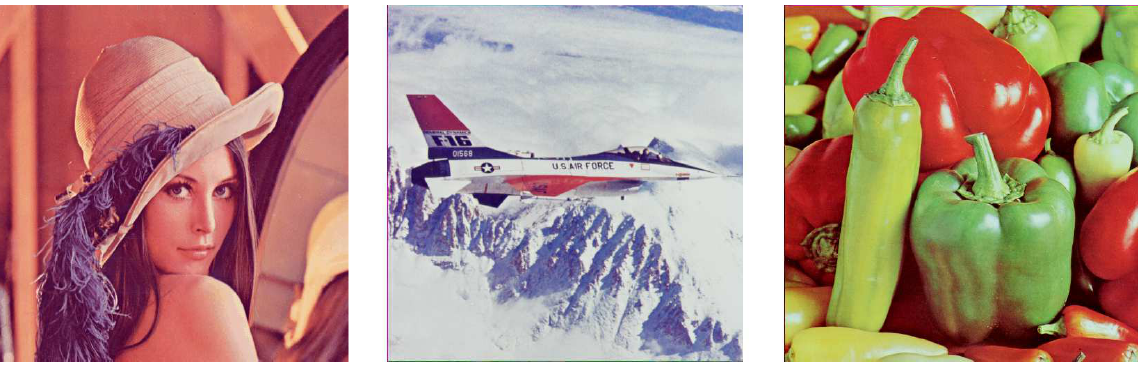
Figure 4. Color BMP test